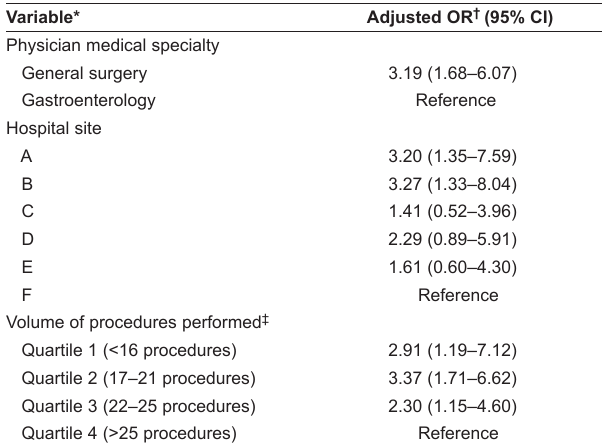
TABle 3 Multivariate logistic regression analysis for overall incomplete colonoscopies performed in